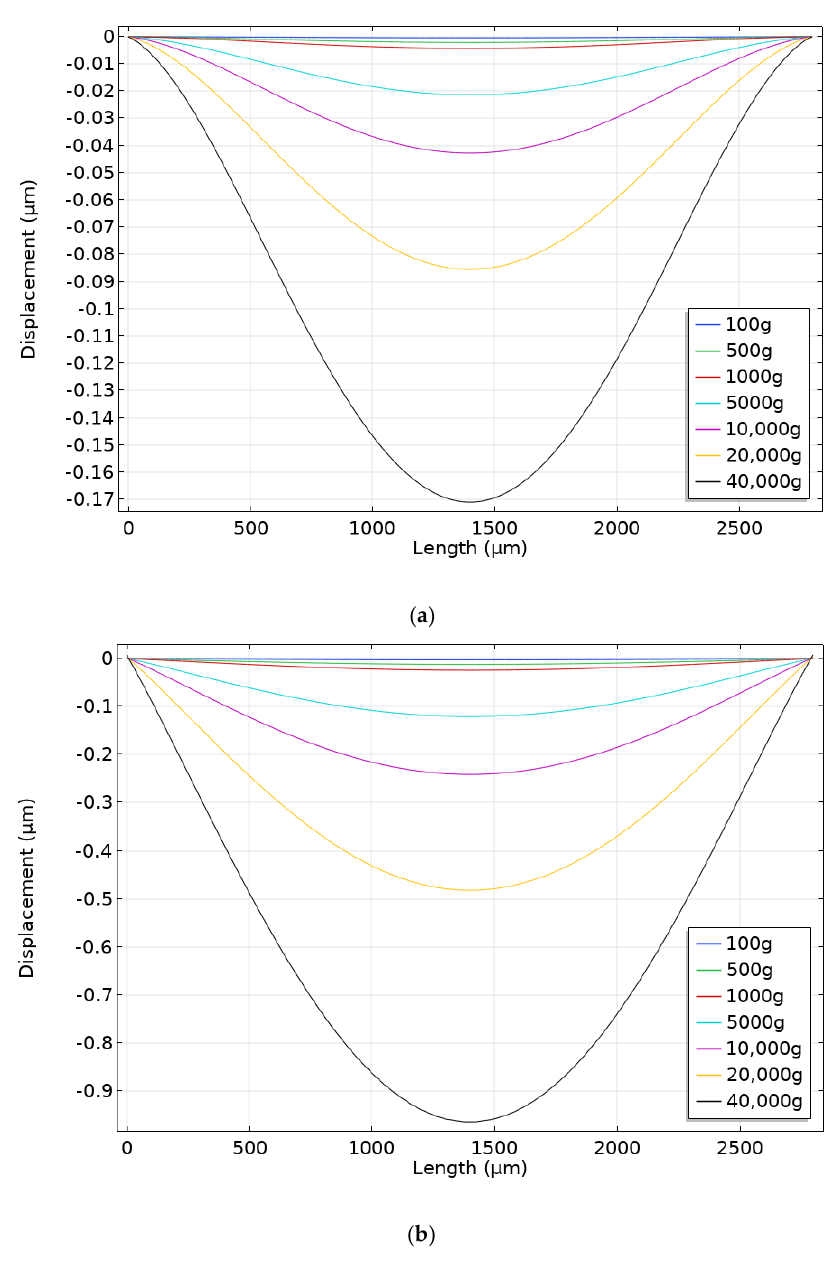
Figure 5. Console displacement with rigid attachment ( a ) and silicon adhesive ( b ).